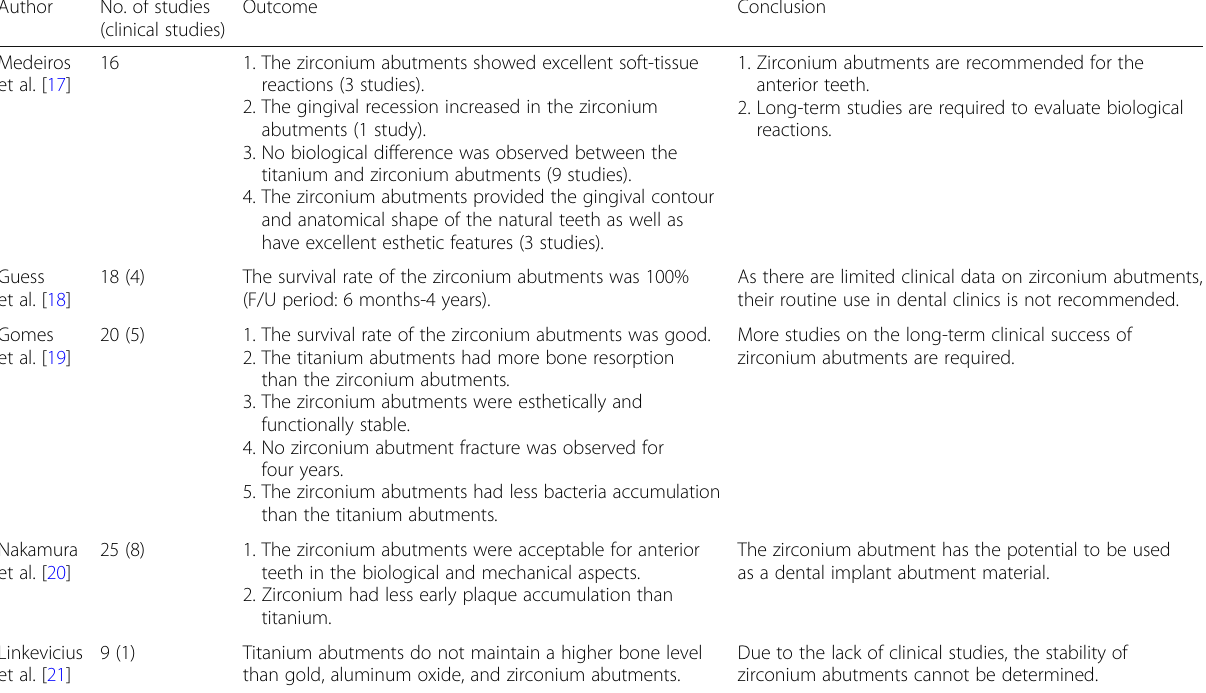
Table 5 Summary of international studies with evidence level